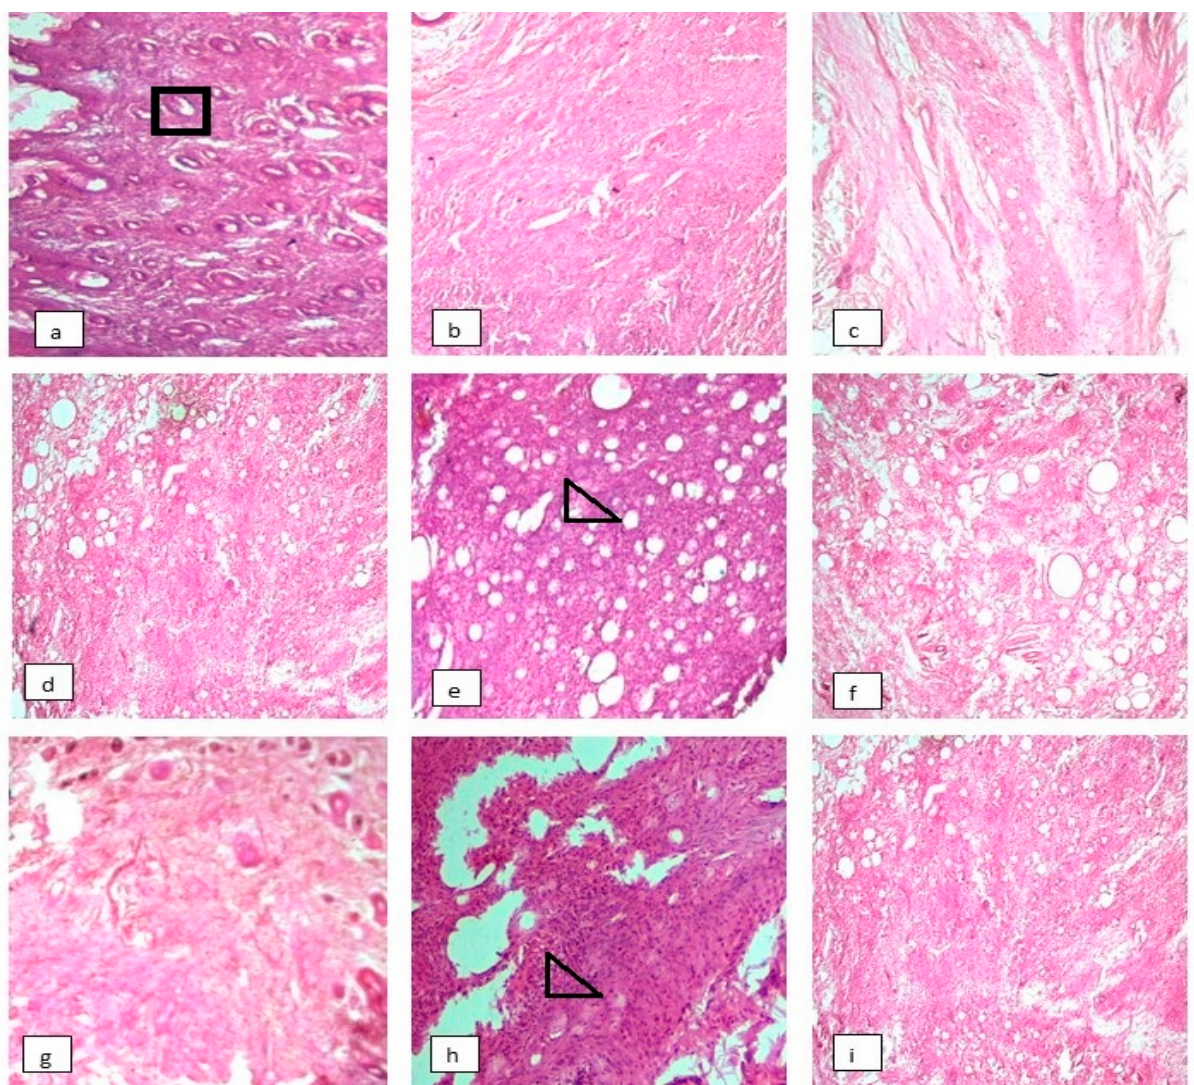
Figure 7. Effect of Caralluma tuberculata on histopathology of arthritic rats at 10× magnification. The tissues were stained with H & E stains. Here ( a ): Normal control group; ( b ): Disease control group; ( c ): Standard control group; ( d ): CTME150; ( e ): CTME 300; ( f ): CTME 600; ( g ): CTAQ 150; ( h ): CTAQ 300 and ( i ): CTAQ 600. Where square showed hair follicle and triangle showed chronic inflamma- tion.